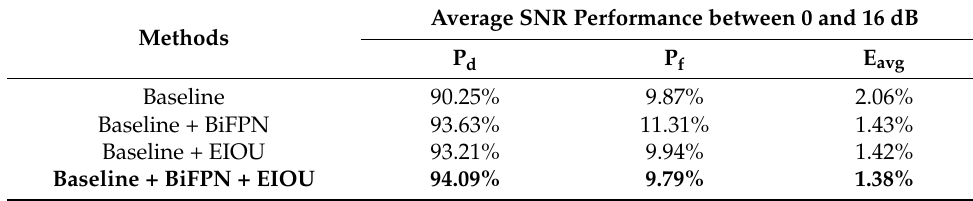
Table 2. Comparison of the average parameter indicators of the four methods.